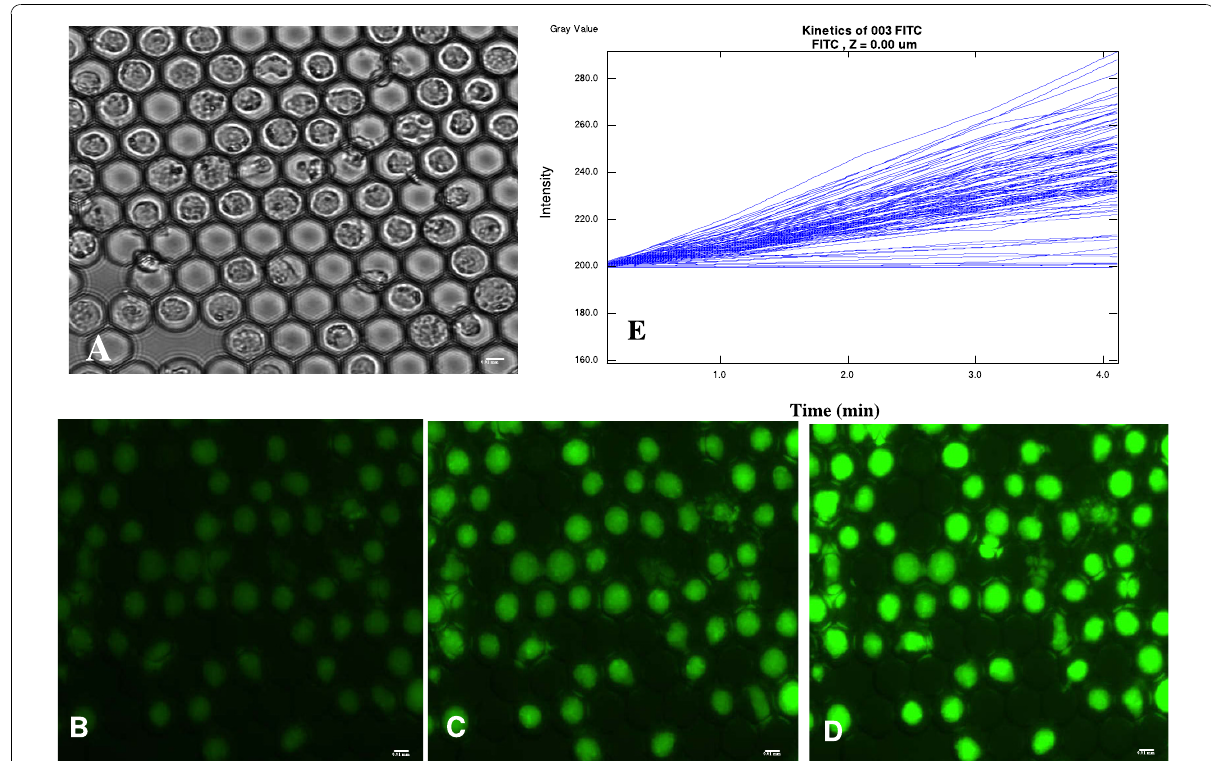
Figure 6 Metabolic characteristics of U937 cells that underwent a freezing and thawing cycle in the i3C . At 3 hours after thawing the cells were stained by FDA (1.2 μ M) and the kinetics of FI increase were measured. Transmitted light image (A) and the corresponding